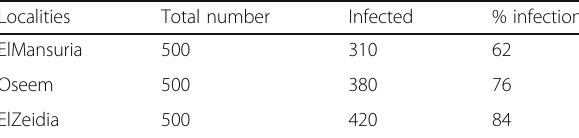
Table 2 Percentage (%) of infection in snails detected by shedding and crushing techniques in three localities in